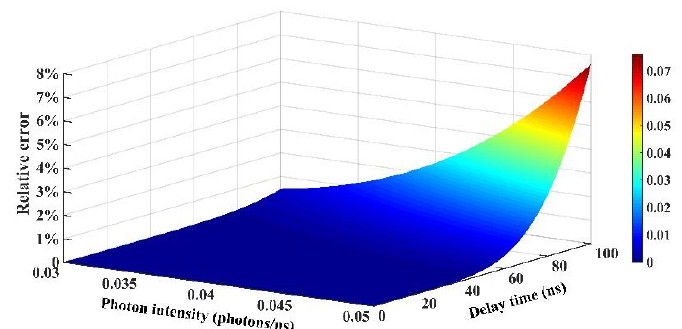
Figure 6. The relative error varying with the photon intensity and delay time. The coherence time is set as one ns.